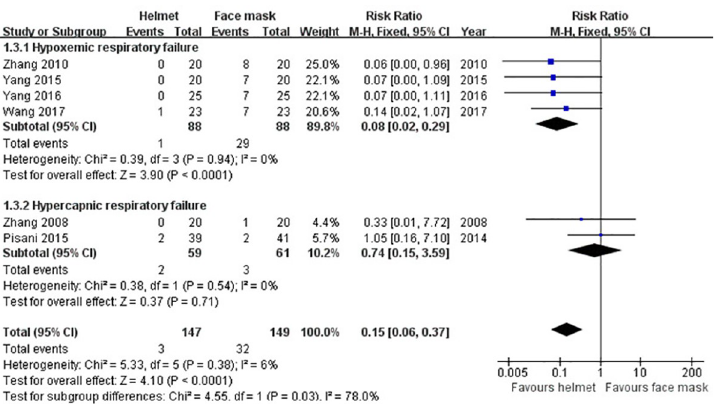
Fig 6. Forest plot of